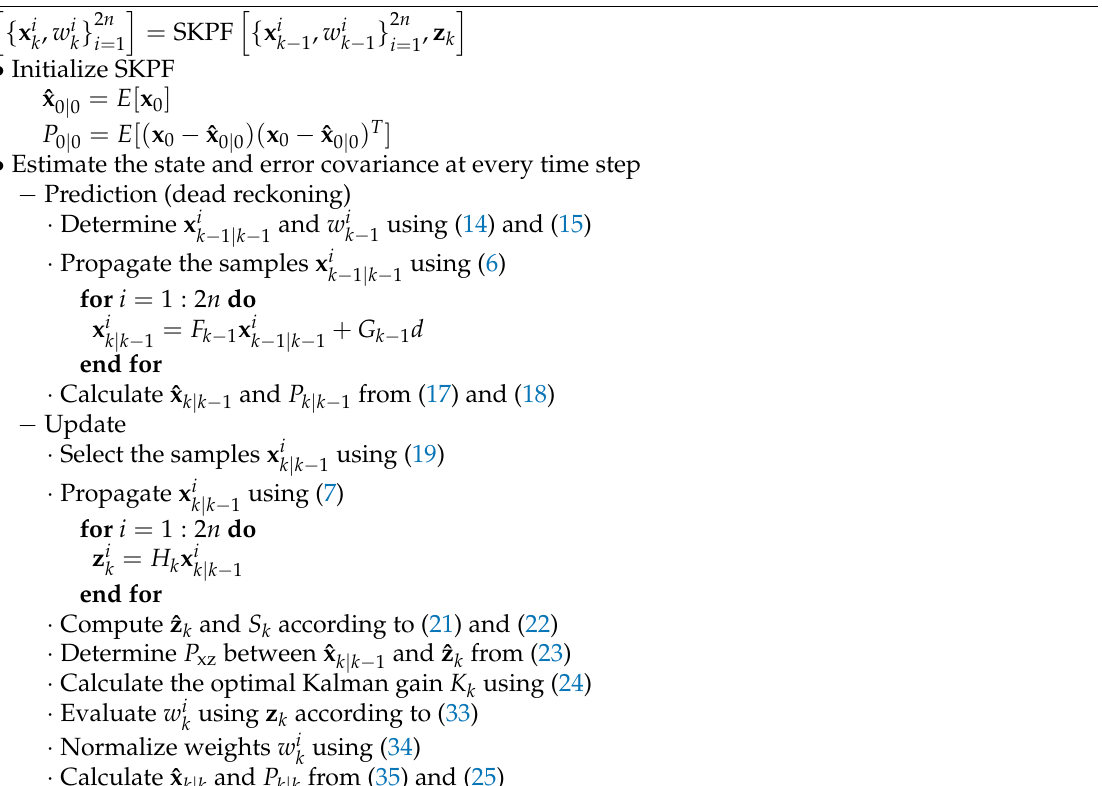
Algorithm 1 SKPF-based Localization